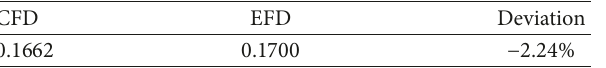
Figure 24: Influence of cross flows on the exciting forces of one